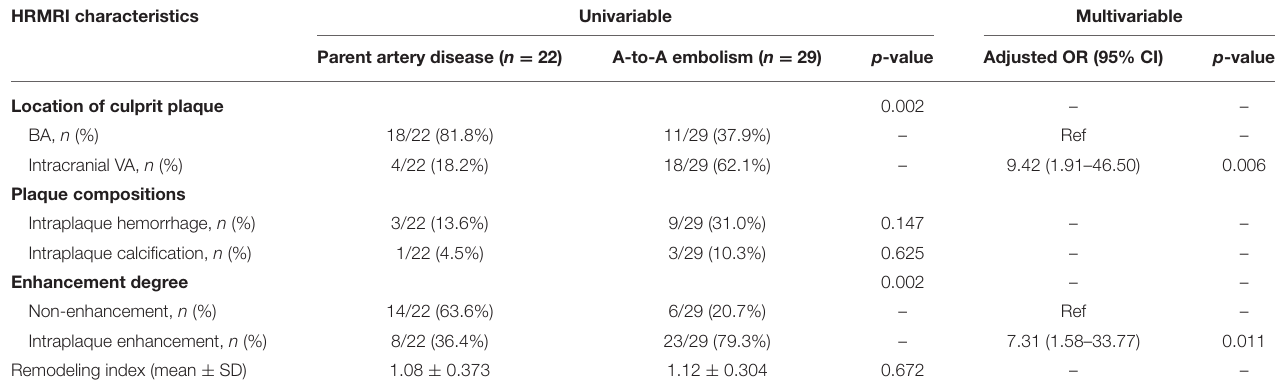
TABLE 3 | Comparison of culprit plaque characteristics between the parent artery disease group and the A-to-A embolism group. HRMRI characteristics